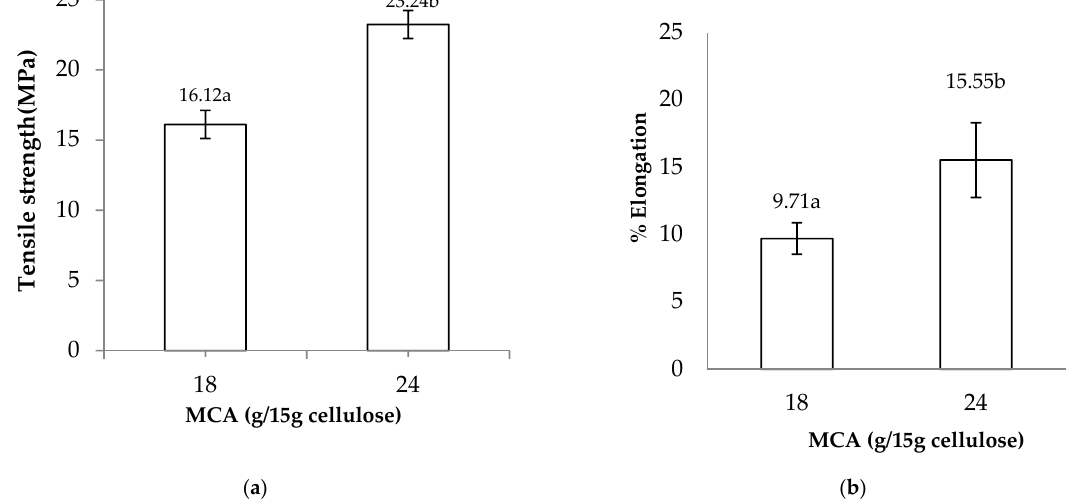
Figure 8. Effects of various MCA levels (18 and 24 g/15 g of cellulose) on ( a ) tensile strength and ( b ) percent elongation at break of CMC n films. The different letter, e.g., ‘a’ and ‘b’ are statistically different ( p < 0.05).